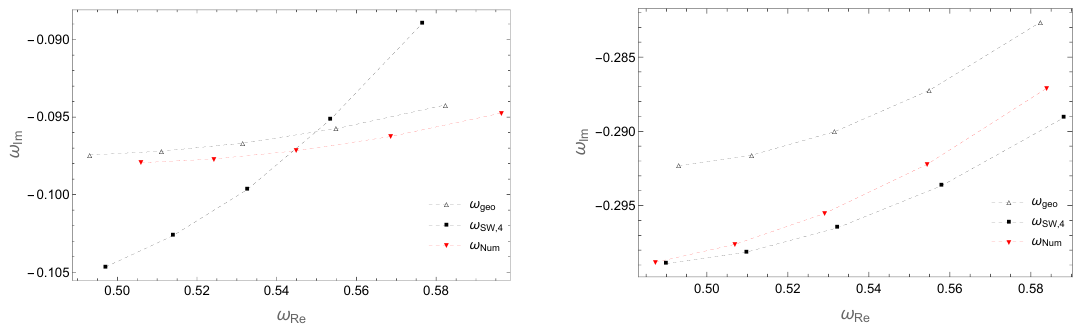
Figure 3 . QNMs of a KN BH for n Num = 1 (left) and n Num = 2 (right), ‘ = m φ = 2 , with Q = 0 . 5 , varies between 0 and 0 . 4 M = 1 , a J